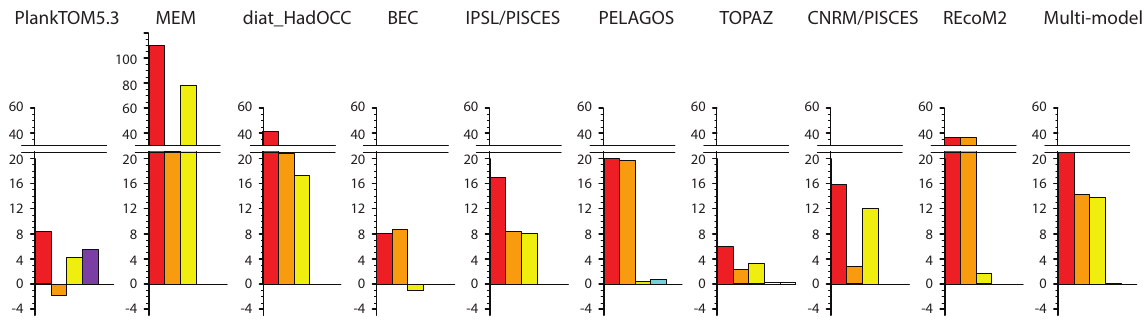
Figure 11. Decomposition of Southern Ocean (50–90 ◦ S) surface NPP changes between 2012–2032 and 2080–2100 (red bar, in molCm − 2 yr − 1 ) into change in nanophytoplankton (yellow) and diatom (orange) surface NPP. Changes in diazotrophs (green) and pico- phytoplankton (light blue) have been included in the bar indicating nanophytoplankton changes for the models that simulate these functional types. For TOPAZ, changes in large non-diatom phytoplankton (dark blue) are included in the bar indicating diatom changes. Changes in coccolithophore NPP are shown in purple. Note the change in scale between the first three plots (models with large surface NPP changes) and the remaining six plots. While for diat-HadOCC, BEC, IPSL–PISCES, CNRM–PISCES, REcoM2 and TOPAZ, the surface NPP of the PFTs was included in the model output, we show recalculated values for PlankTOM5.3, MEM and